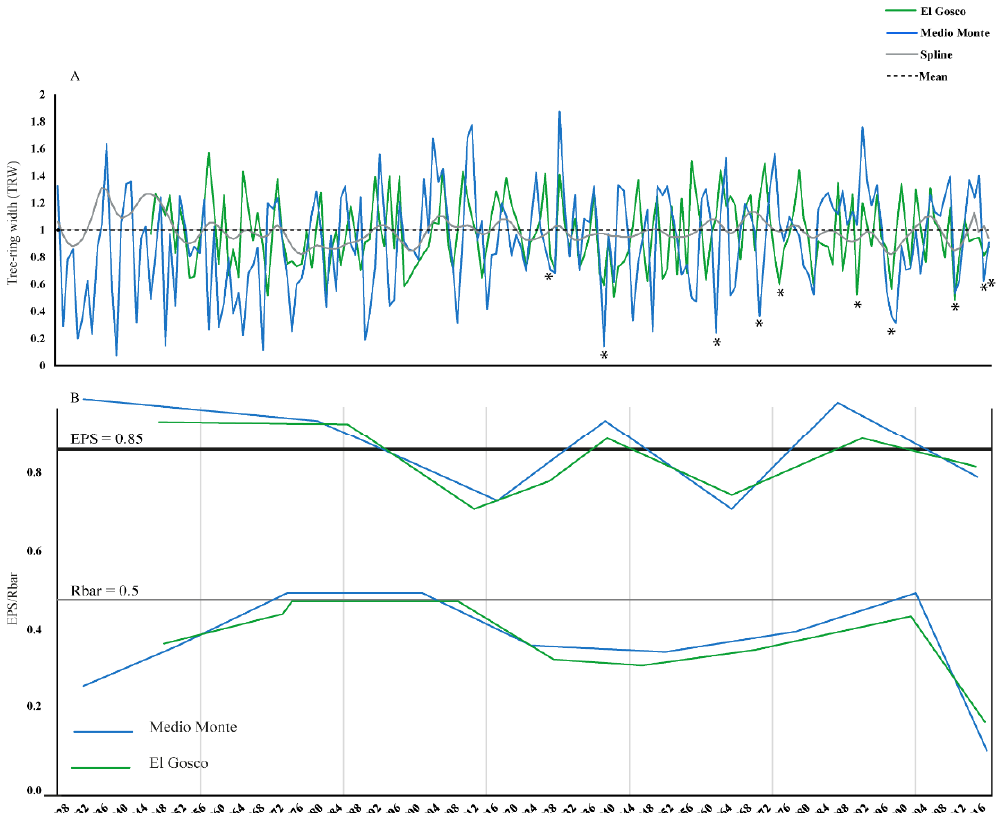
Figure 4. ( A ) Ring-width chronologies of M. schiedeana from Medio Monte and El Gosco localities.